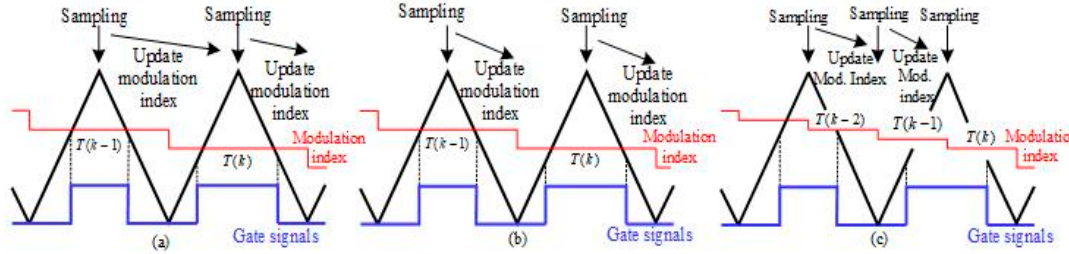
Figure 12. Time delay model of a VSI ( a ) single-update time delay model (sampling at beginning) ( b ) single-update time delay model (sampling at middle) ( c ) double-update time delay model for a VSI.